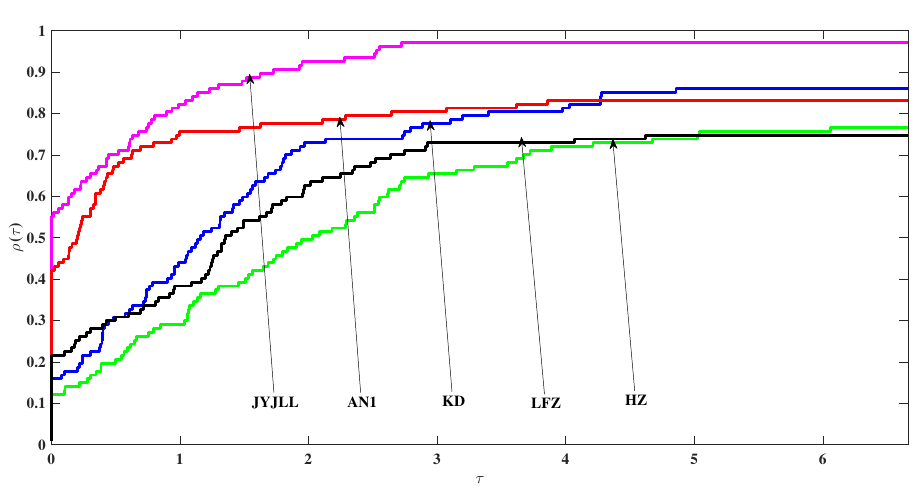
Figure 4. Performance profiles on